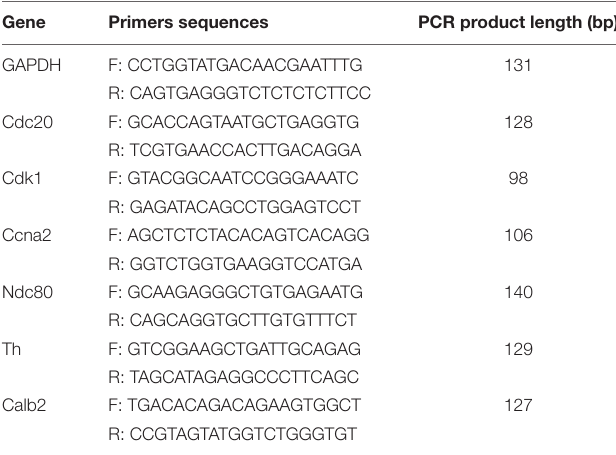
were the top10 enriched cellular components. The enriched TABLE 3 | Primer